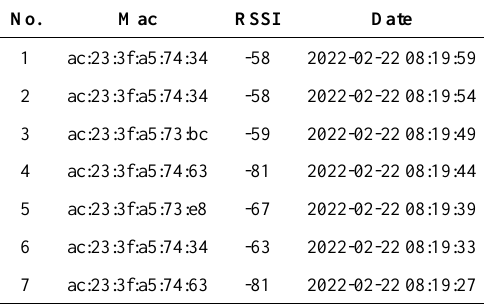
Figure 6. Stage 1 Experimentation Set Up Table 1. Sample of Captured